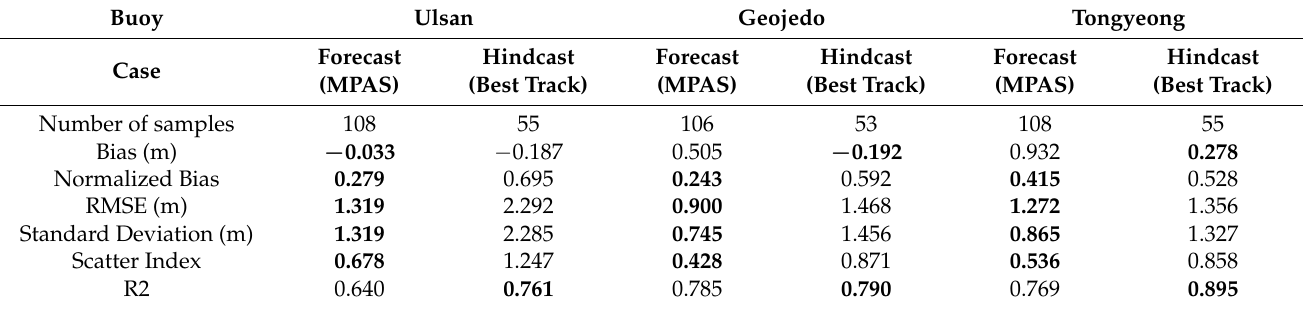
Table 6. Same as Table 5, except for typhoon